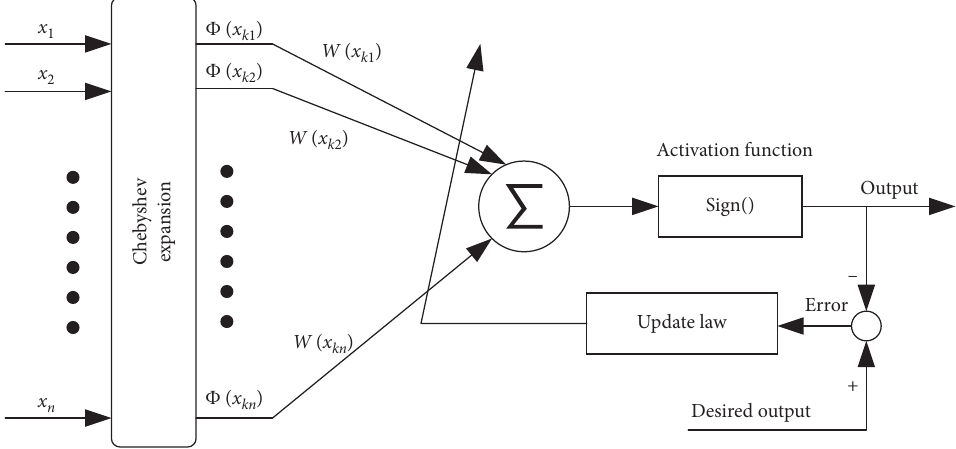
Figure 2: The structure of the Chebyshev neural network.